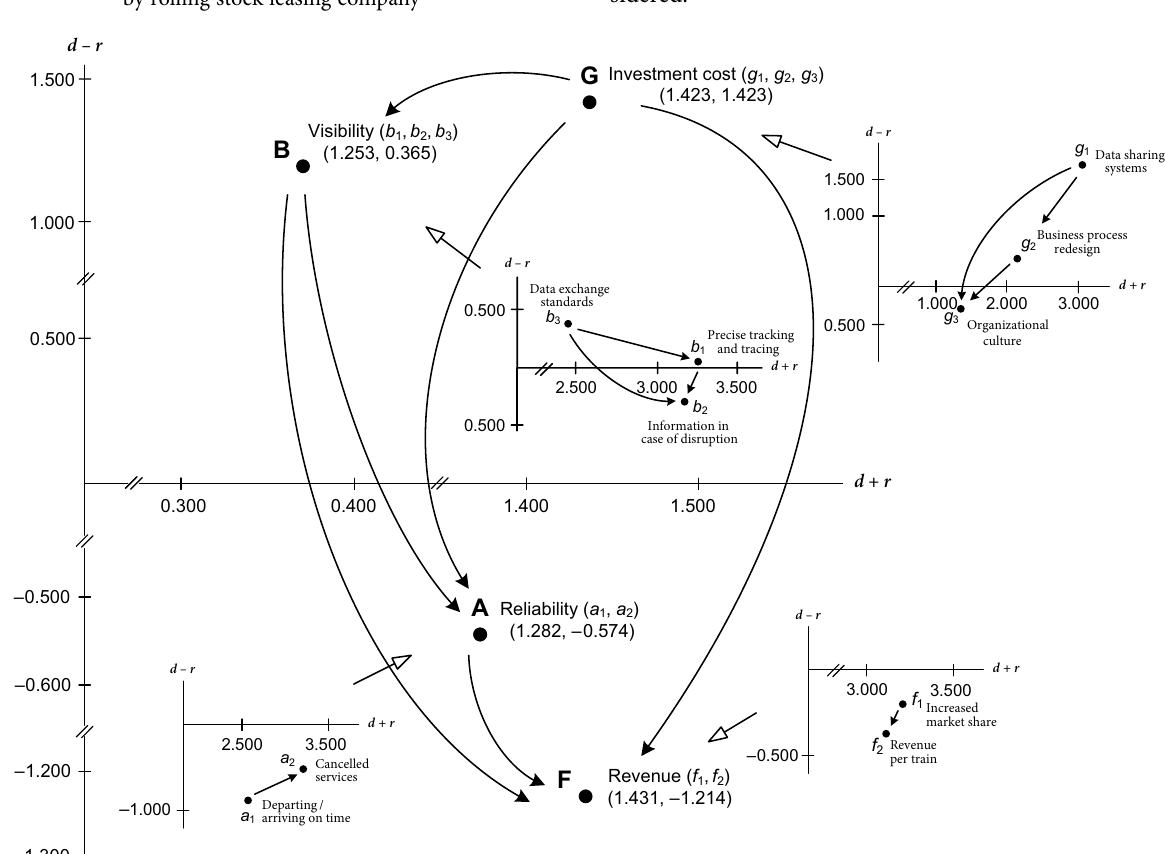
Figure 16. Causal diagram of total relationships: rolling stock leasing companies’ perspective Table 10. Influential weights of DEMATEL–ANP for each criterion obtained